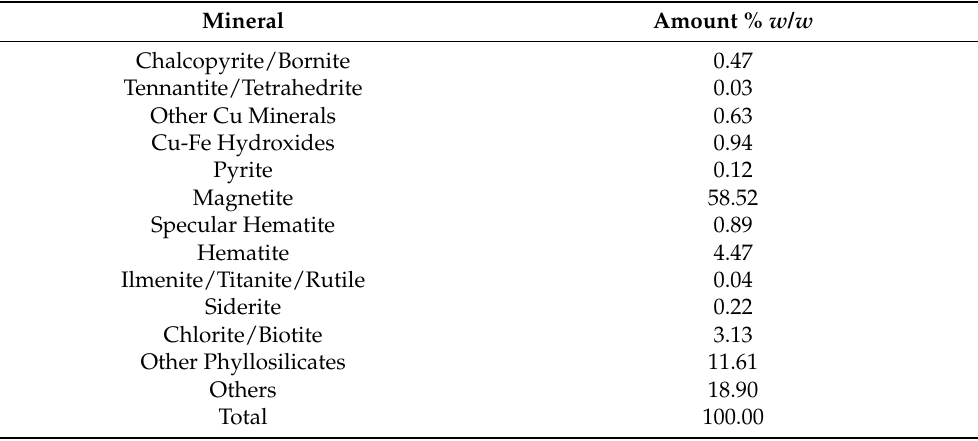
Table 4. Mineralogical composition of tailings assessed by QEMSCAN.